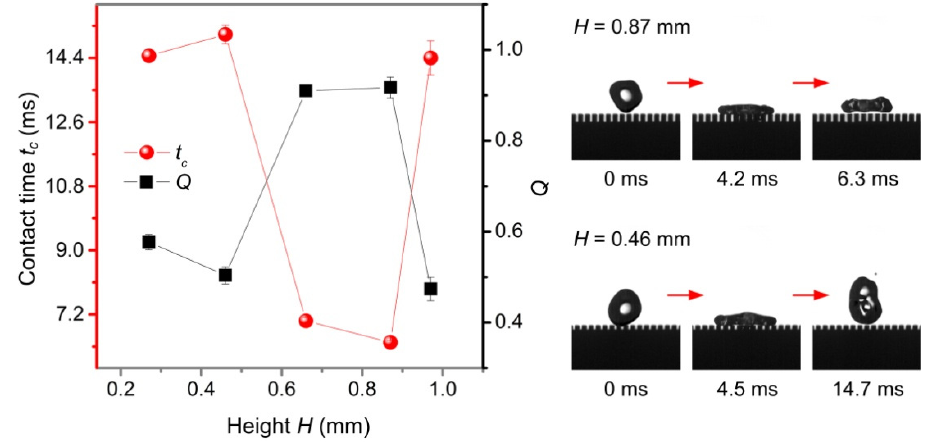
Figure 11. Contact time t c and Q of water droplets in a three-level structured plane surface as a function of height H .